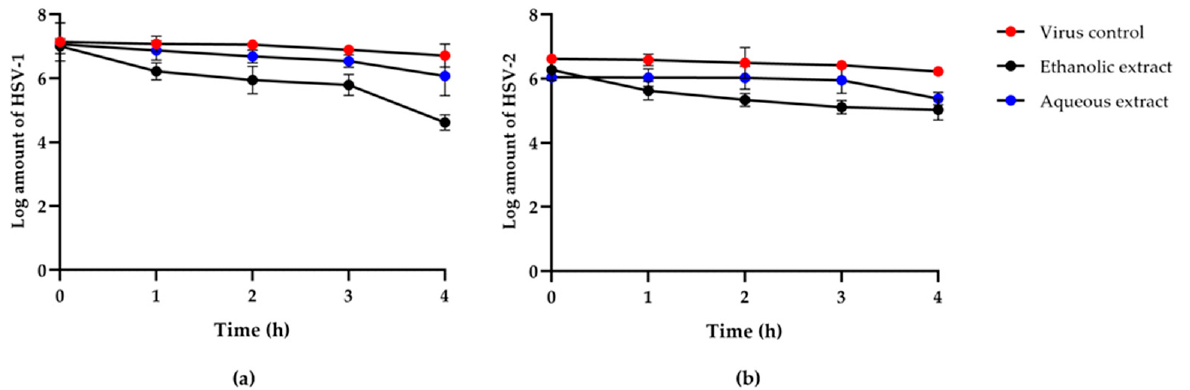
Figure 3. Log titers of HSV-1 ( a ) and HSV-2 ( b ) titer at 0, 1, 2, 3, and 4 h after treatment with the extracts from ethanolic and aqueous extracts of red jasmine rice, compared to viral control.